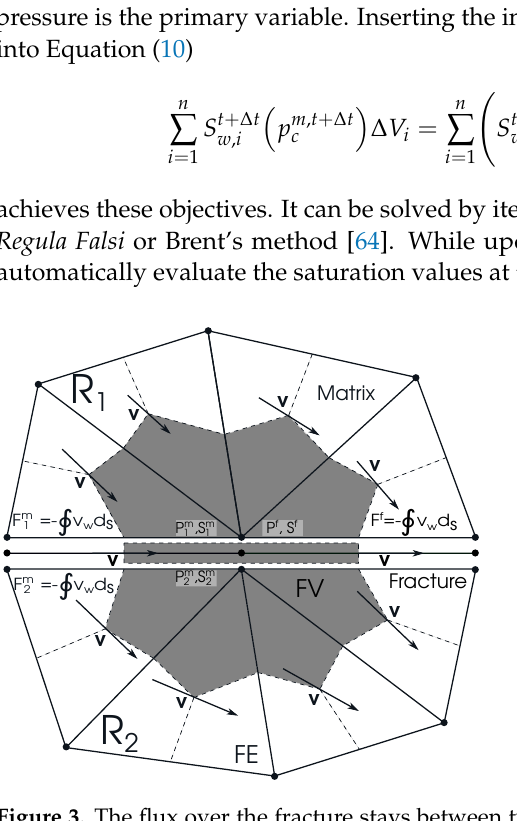
Figure 3. The flux over the fracture stays between two material patches R 1 and R 2 . Velocity field v are constant within elements; Nodal saturation values of matrix and fracture are generally not the